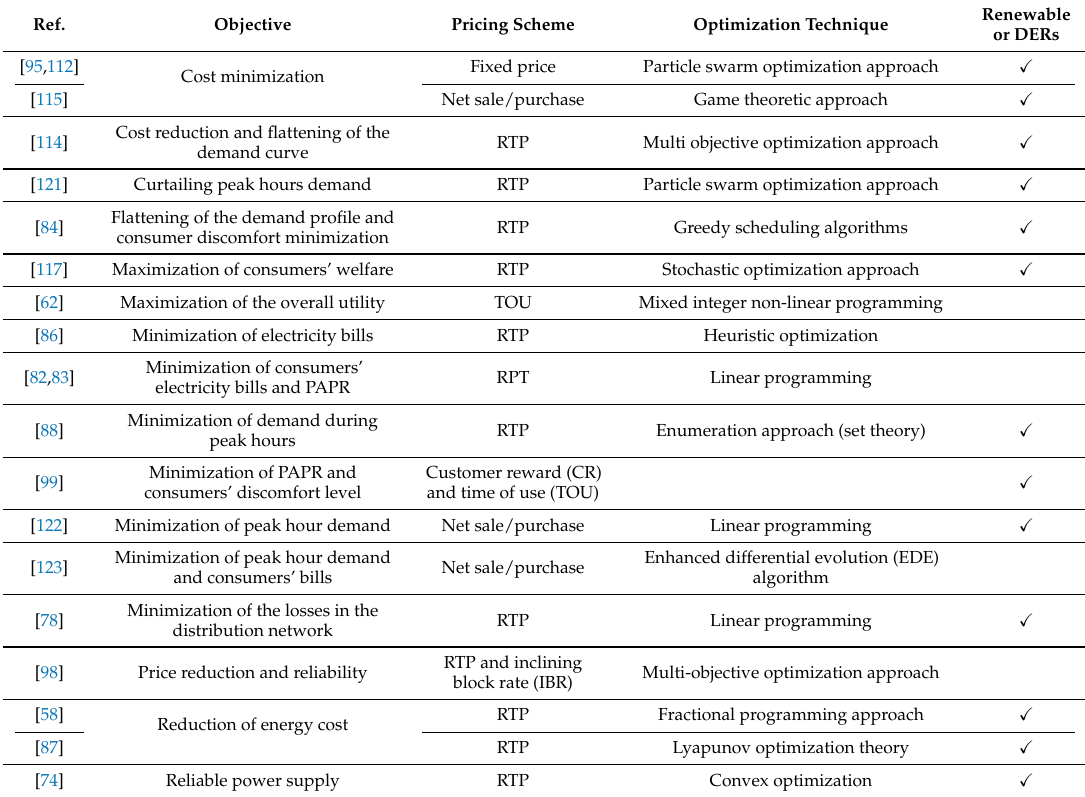
Table 8. Categorizes of the existing DSM schemes on the basis of pricing schemes and DERs.